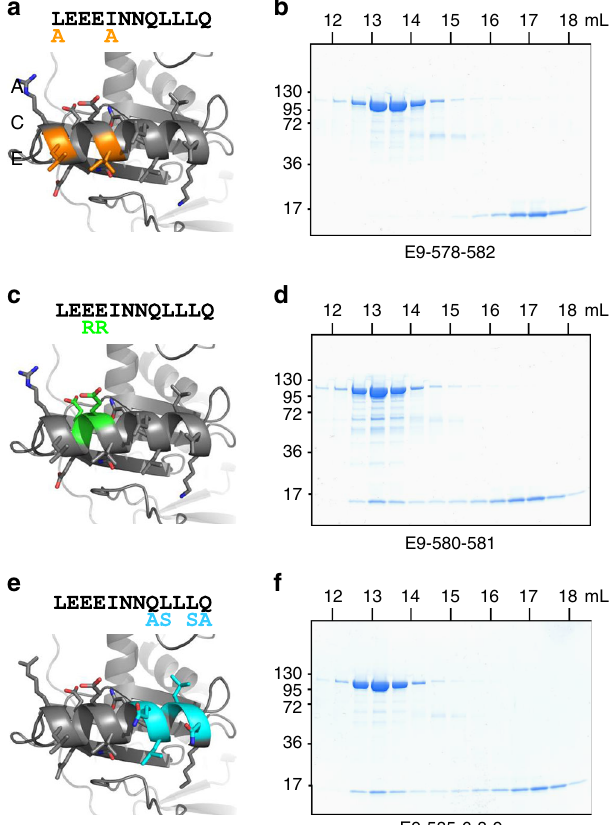
Fig. 4 Mutational analysis of E9 insert 3 regarding A20 C-ter binding. a , c , e Crystal structure of E9 insert 3 (gray) with mutated residues highlighted. The corresponding sequence of the α -helix of insert 3 (black letters) is shown with mutated amino acids depicted as colored letters. b , d , f Each E9 mutant was mixed with WT A20 C-ter prior to analysis by size exclusion chromatography. A 4 – 20% SDS-PAGE analysis of the eluted fractions for each of the runs is